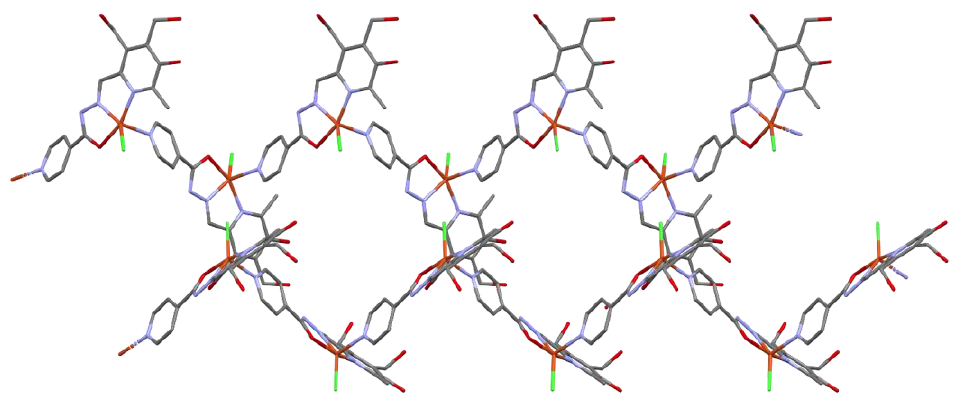
Figure 4. Polymeric expansion of 1 ∞ { [ Cu L Cl ] · 0.5H 2 O } along the a axis. Cu—brown, Cl—green, N—blue, O—red, C—grey. H atoms are omitted for clarity.